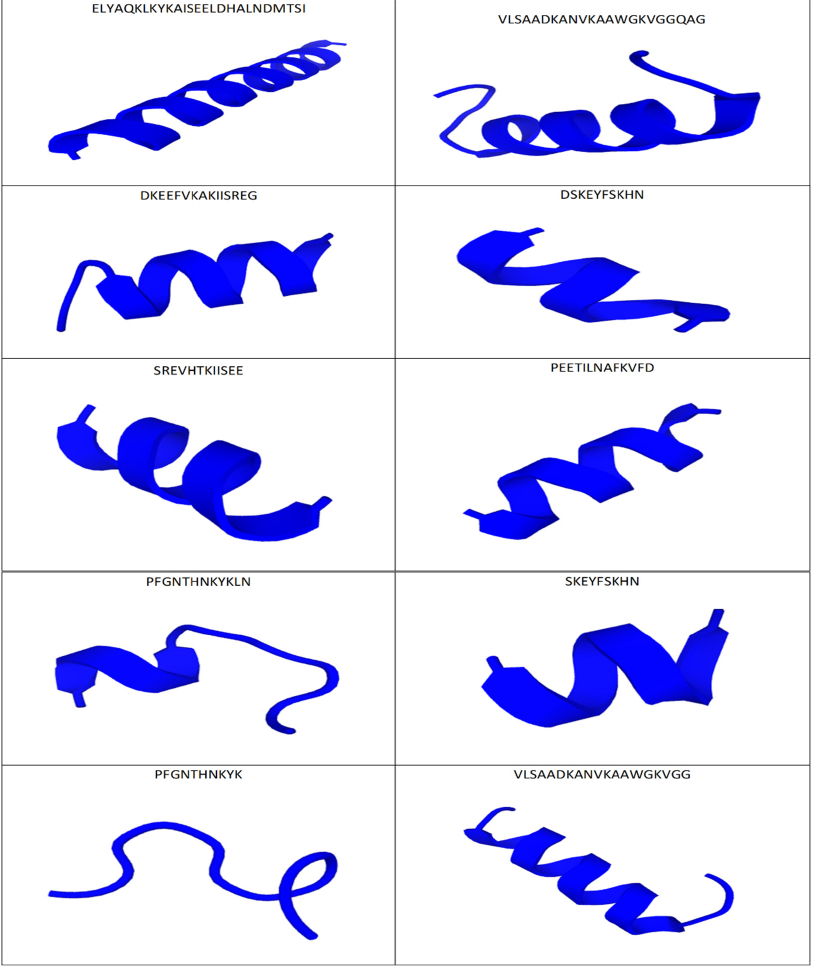
Figure 3. De novo 3D models of selected sequences of peptides with potentially anticancer activity derived from canned pork after 6 months of refrigerated storage irregular sequence— , helix ,helix sequence— .